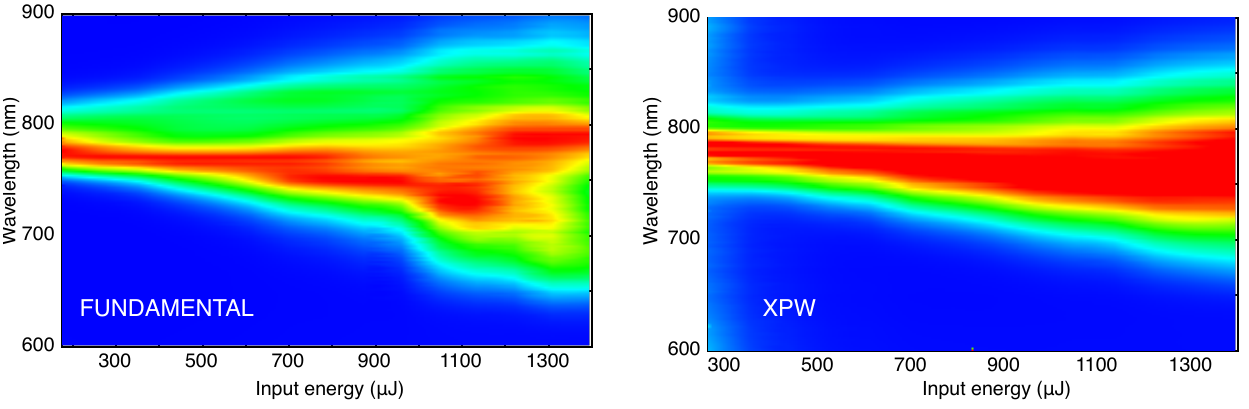
Figure 3. Fundamental (measured after the nonlinear interaction) and XPW normalized spectra as a function of laser input energy. Each spectrum is averaged over 500